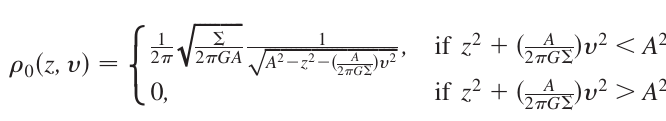
ffiffiffiffiffiffiffiffiffiffi